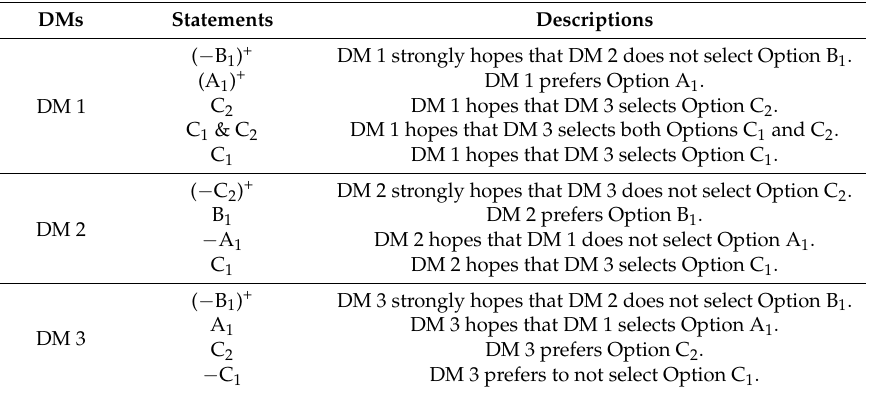
Table 5. DMs’ preference statements.